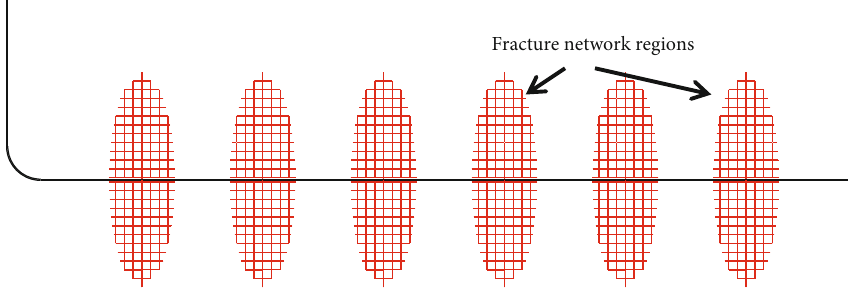
Figure 1: Schematic of fracture distribution of shale gas horizontal